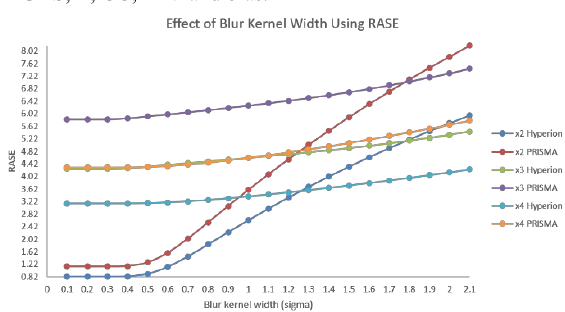
Figure 3. Effect of Blur Kernel Width Using RASE on IBP’s Performance RASE figures lie between 0.82 – 8.02. Irrespective of SF, Hyperion’s RASE values are lower than PRISMA’s RASE values. For SF=2, there is a steep rise in RASE values from σ = 0.5, size = 6 x 6 to the highest RASE at σ = 2.1 , size = 16 x 16 RASE values for x3 Hyperion and x4 PRISMA almost overlap each other until σ = 1.3 . For each SF, lowest RASE exists for σ = 0.1, size = 4 x 4 in case of SFs 2 and 4 and size = 3 x 3 in case of SF =